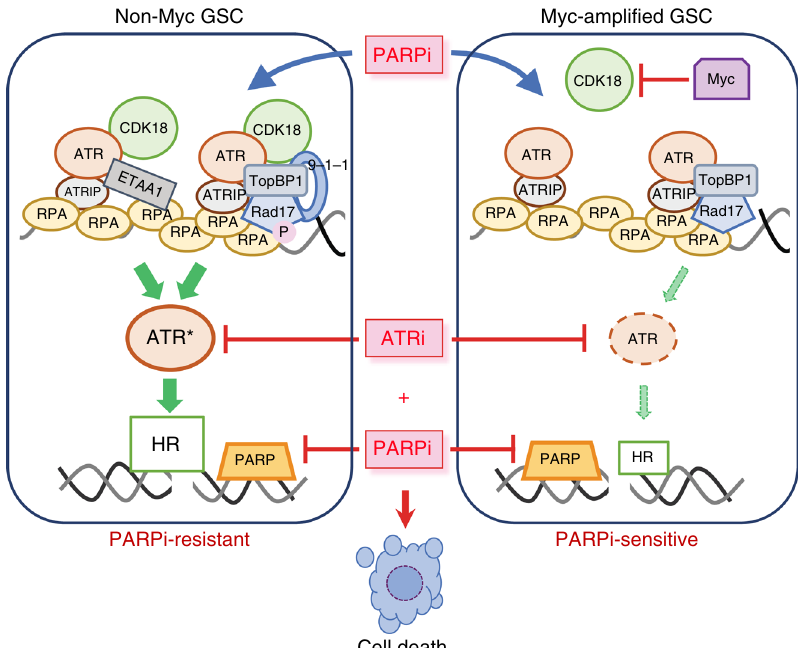
Fig. 9 Model for Myc/cyclin-dependent kinase 18 (CDK18) regulation of ATR signaling and poly(ADP-ribose) polymerase inhibitor (PARPi) sensitivity in glioblastoma stem-like cells (GSCs). In non-Myc GSCs (left), CDK18 fully activates ATR via ATR-ETAA1 and ATR-TopBP1 complexes containing Rad9 (9-1- 1) and Rad17, which increases homologous recombination (HR), and generates PARPi resistance. In Myc-ampli fi ed GSCs (right), Myc ampli fi cation/ overexpression inhibits CDK18 expression so that CDK18 interactions with ATR signaling complexes after PARPi-induced DNA damage are lacking, leading to suppressed ATR signaling and HR, which generates PARPi sensitivity. ATRi sensitizes both non-Myc GSCs (PARPi-resistant; left) and Myc overexpressing GSCs (PARPi-sensitive; right) to PARPi killing (cell